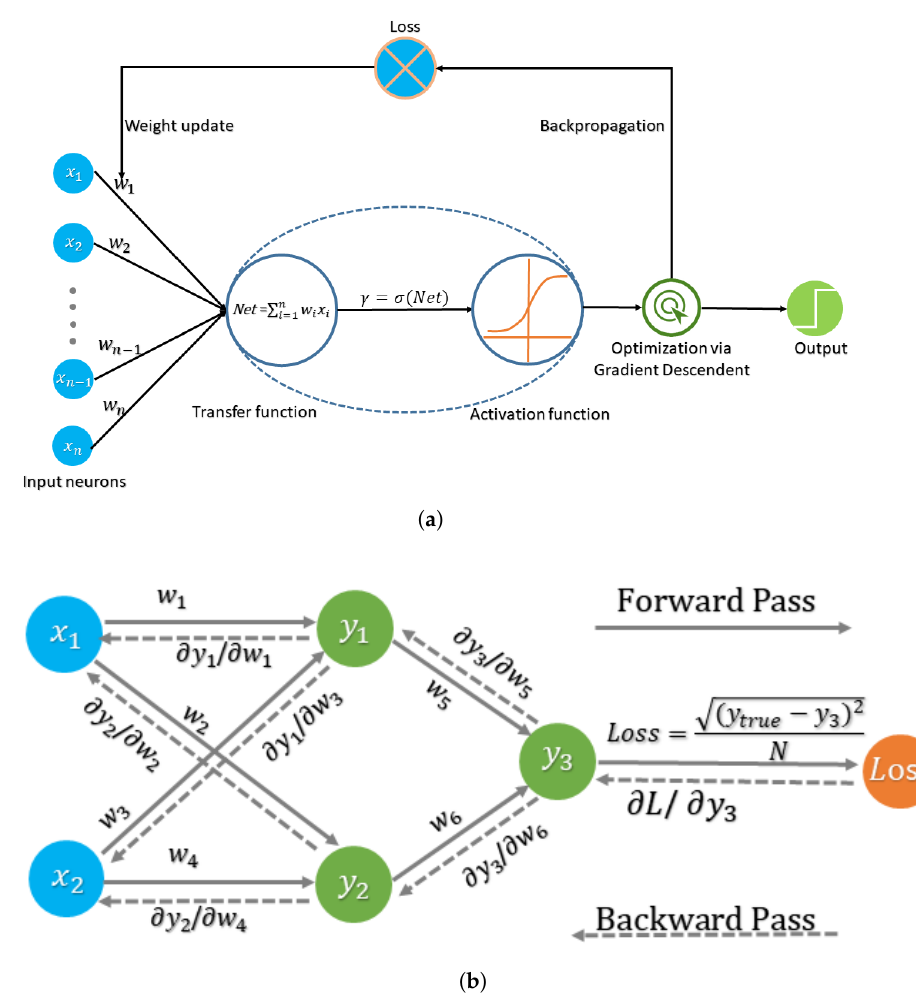
Figure 2. An overview of backpropagation. ( a ) Role of backpropagation in a neural network; ( b ) Step-by-step backpropagation